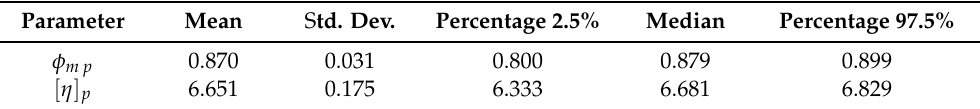
Table 4. Statistics of the parameters φ m p and [ η ] p